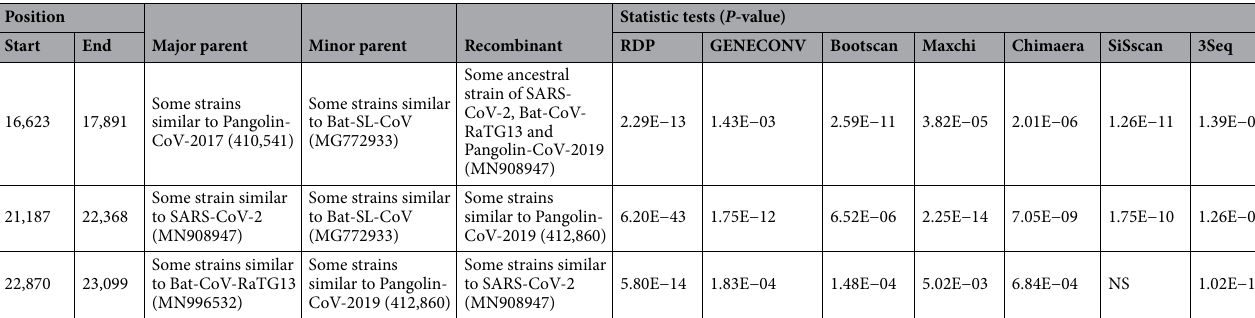
Table 1. Three putative recombination events between bat and pangolin coronaviruses. ‘Position’ refers to the start and end of the reference genome MN908947 (SARS-CoV-2). ’NS’ means not significant. The major parent and minor parent are the presumed parent contributing the larger fraction of the sequence and the presumed parent contributing the smaller fraction of the sequence, respectively. In cells, following the strain name, a representative strain ID is listed within a pair of small brackets. P-values based on seven statistical tests are also listed. Plots of alignments supporting these recombination events are shown in Fig. S1. Sequence IDs in brackets are exemplary sequences of the described